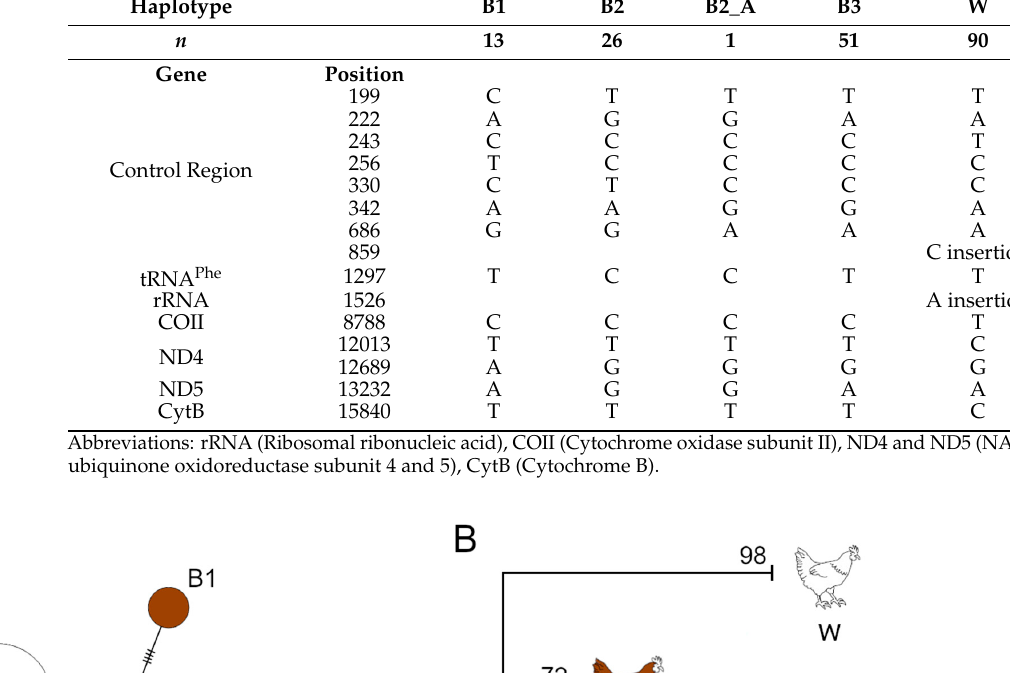
9 Table 4. Number of individuals per haplotype and diet obtained from experiment 2. Haplotype/Diet